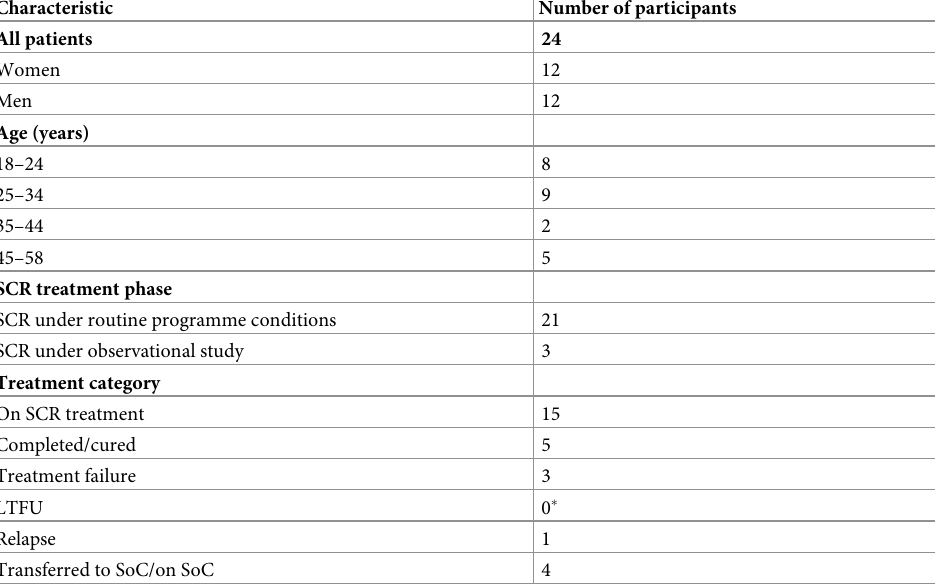
Table 1. Patient